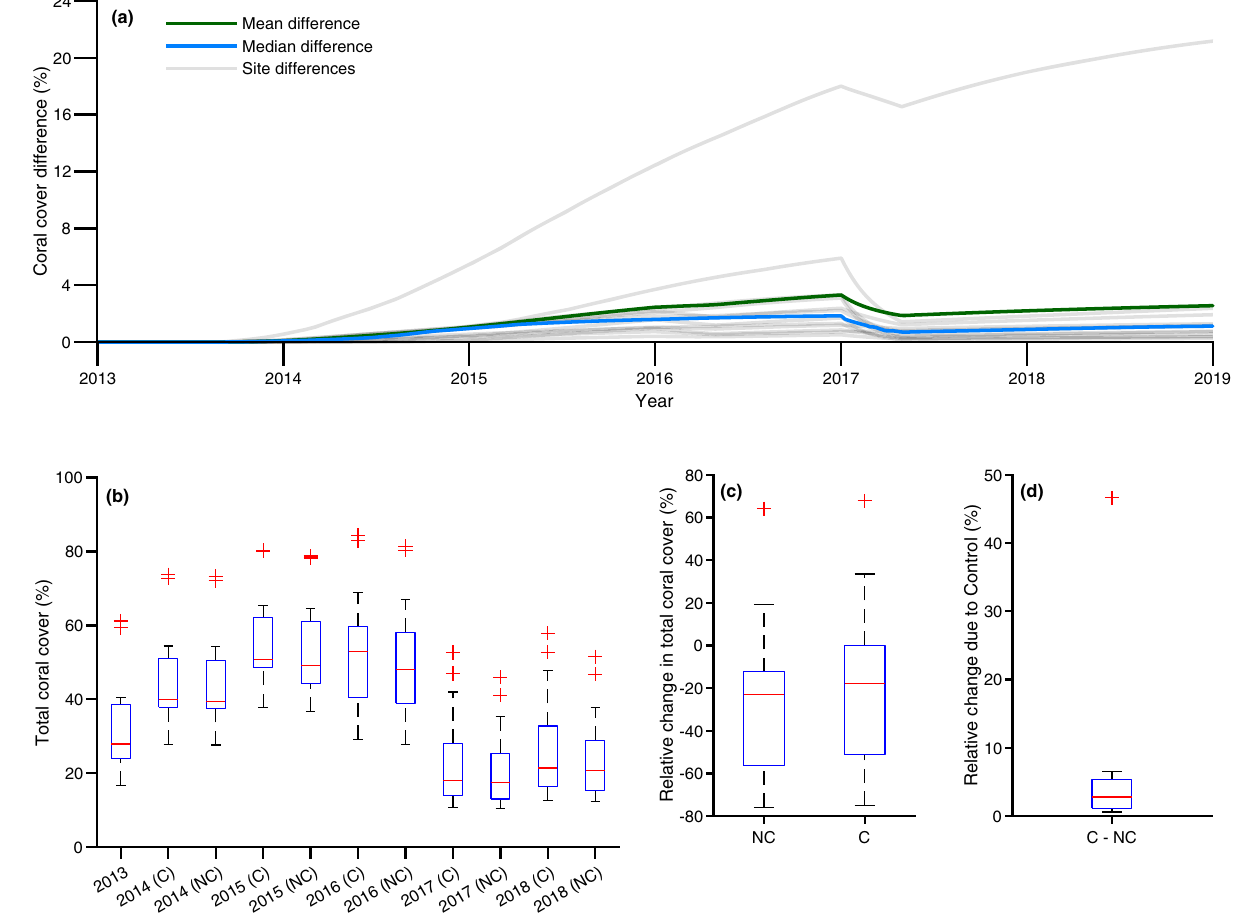
Fig. 7 Sensitivity for model outputs over the data period of 2013 – 2018. Figure is based on model outputs over 2013 – 2018 (June used as observed data ranged from mid-2013 to mid-2018 for most sites) which used undertaken control efforts by the Crown-of-Thorns Star fi sh (CoTS) Management Program as input (e.g. site visits and dive time) to inform potential coral trajectories in its absence. Sensitivity considered no adaptive and acclimation capacity ( A ¼ 0). Abbreviation ‘ C ’ denotes ‘ Control ’ (CoTS culling) and ‘ NC ’ denotes ‘ No Control ’ . Boxplots are based on model outcomes for the modelled management sites ( n = 13). a Summary of differences in coral cover between management scenarios of no manual control and inputted observed manual control over years 2013 – 2018. Difference represents the (absolute) difference in coral cover expressed as a percentage as opposed to a proportional difference. Both mean (green line) and median (blue line) differences are plotted alongside the management-induced difference at each Management Site considered (grey lines). b Box and whisker plot indicating median coral cover model output (middle line), the 25th and 75th percentiles (the box) and any outliers (crosses) over years 2013 – 2018 with and without control. c Box and whisker plot indicating the model-suggested relative change in coral cover for 2018 relative to 2013 with and without control, positive values indicate an increase, negative values indicate a decrease and 0 indicates no change. NC: lower adjacent (lower whisker) − 75.9%, 25th percentile (lower box) − 56.4%, median (centre line) − 23.1%, 75th percentile (upper box) − 12.4%, upper adjacent (upper whisker) 19.3%. C: lower adjacent (lower whisker) − 75.1%, 25th percentile (lower box) − 51.3%, median (centre line) − 17.9%, 75th percentile (upper box) − 0.1%, upper adjacent (upper whisker) 33.5%. d Box and whisker plot indicating model-suggested relative change over 2013 – 2018 due to operation on the CoTS control program. Lower adjacent (lower whisker) 0.6%, 25th percentile (lower box) 1.2%, median (centre line) 2.8%, 75th percentile (upper box) 5.4%, upper adjacent (upper whisker) 6.6%. Source data (model outputs) provided, includes boxplot